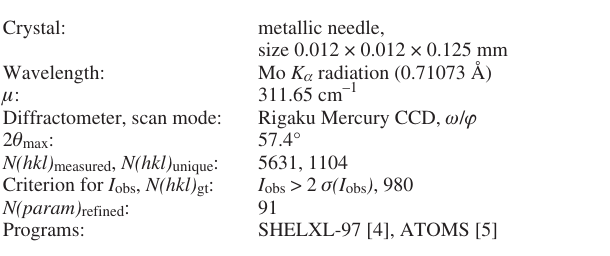
Table 1. Data collection and